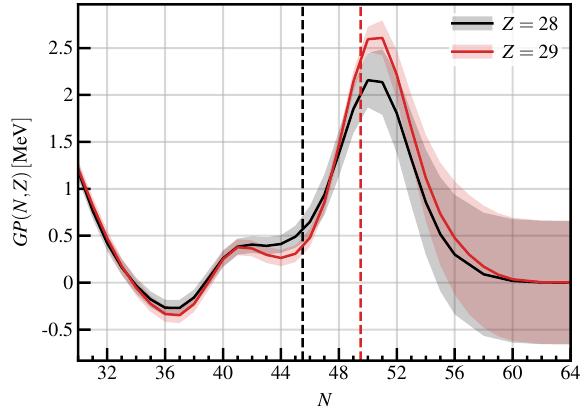
Figure 9. GP correction for Z = 28 and Z = 29. The vertical dashed lines represent the transition from nuclei used for training to nuclei for which predictions are made. The shaded ares represent the GP 1 σ error bars. See text for